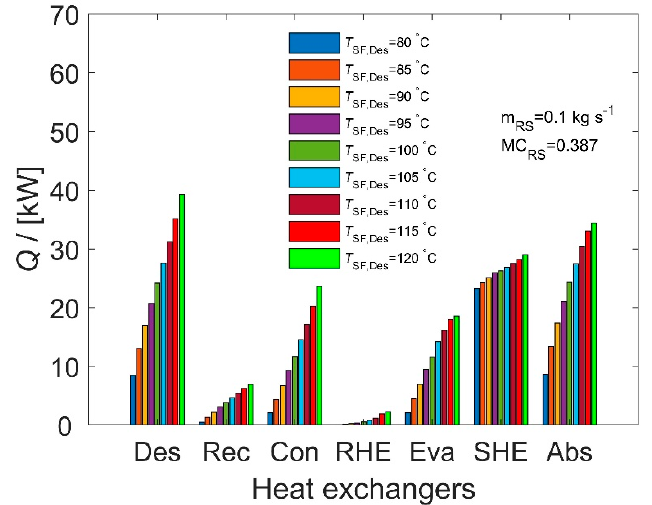
Figure 8. Heat exchanger loads as functions of heat source temperature for the rich solution of 0.1 kg s − 1 and 0.387.